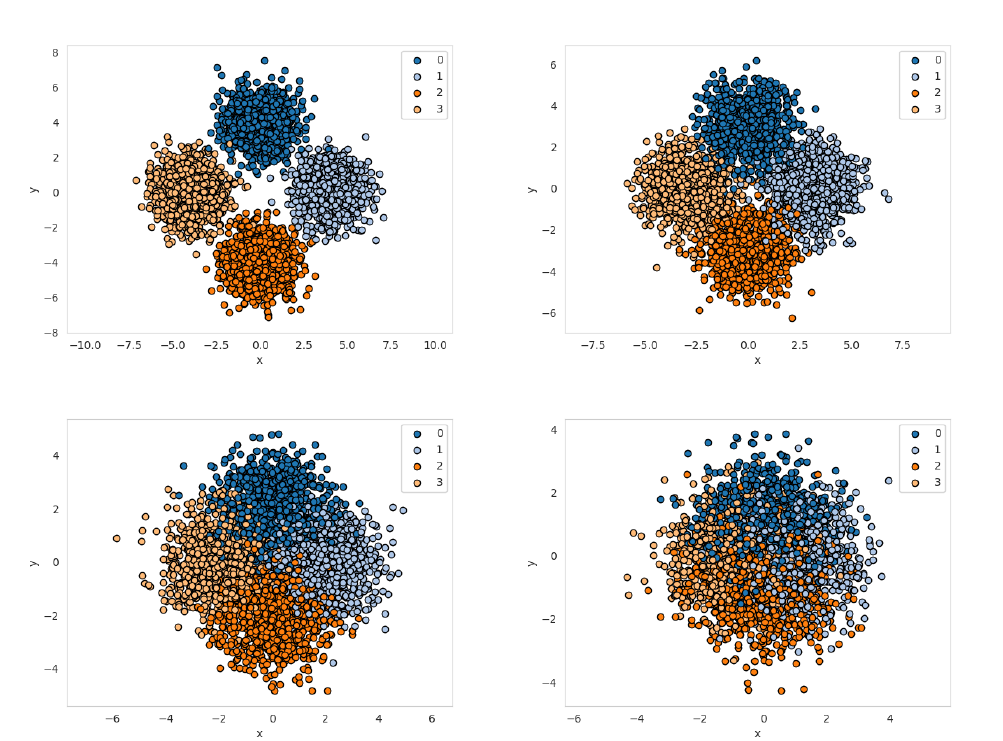
Figure 5. Samples drawn from four variants of the Four Gaussian data set. All Gaussians have σ = 1.0 and their means lie on a circle with radii 4,3,2,1.